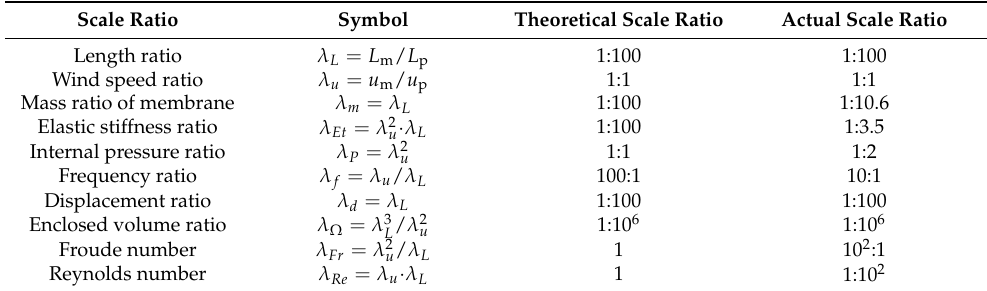
Table 1. Scale ratios of aeroelastic